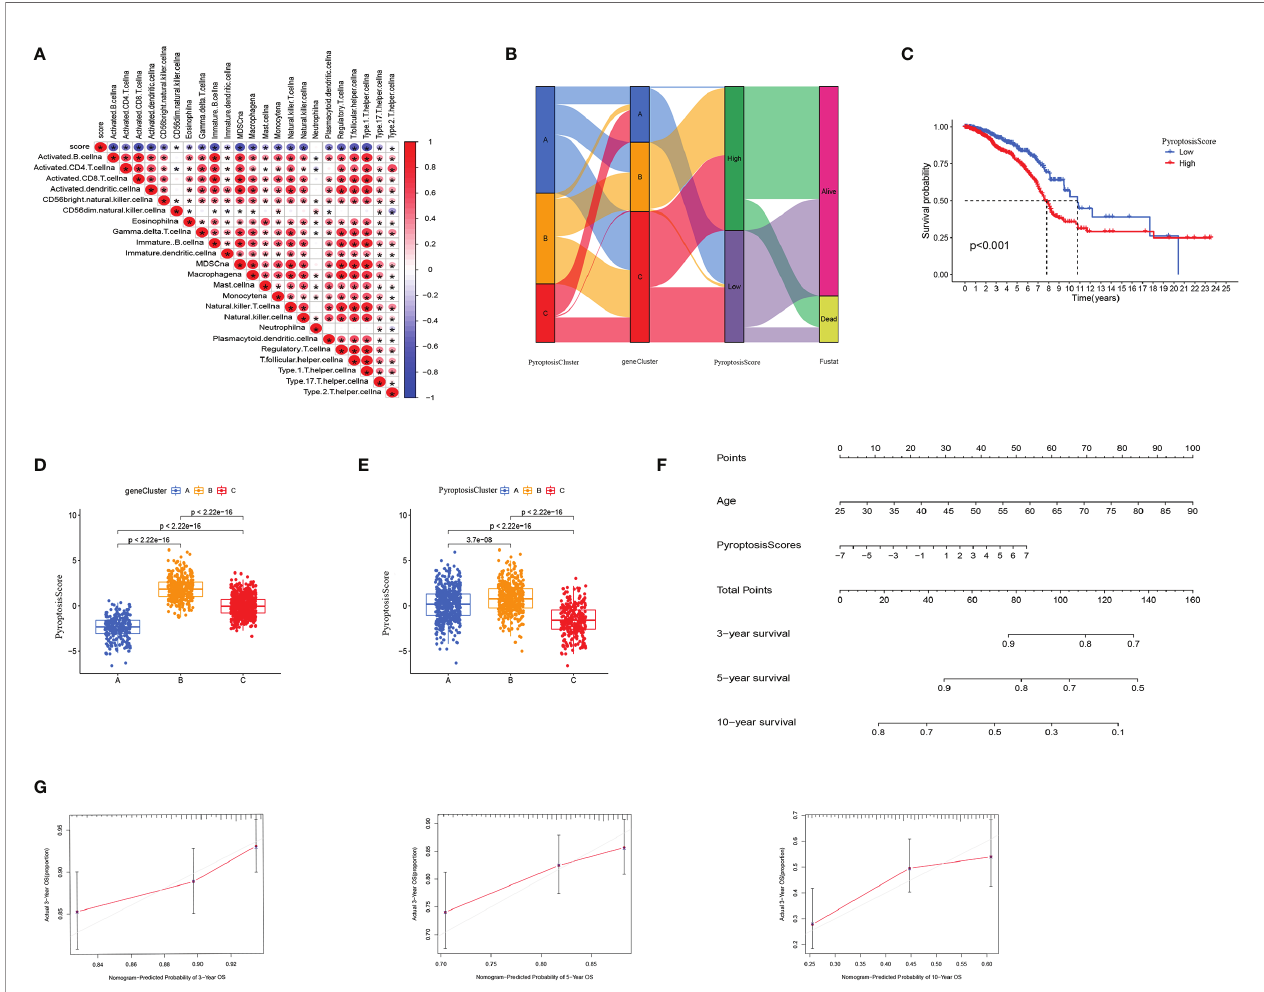
FIGURE 5 | Generation of PyroptosisScore. (A) Correlation between PyroptosisScore and immune cell in fi ltration. (B) Alluvial diagram showing the connection between pyroptosis cluster, gene cluster, and pyroptosis score. (C) The overall survival of PyroptosisScore. (D) The level of PyroptosisScore in different genecluster sub-groups. (E) The level of PyroptosisScore in different PyroptosiscCluster subgroups. (F) Nomogram to predict 3-, 5- and 10-year OS in the TCGA cohort. (G) Calibration plots of the nomogram to predict OS at 3-, 5- and 10-year. * P < 0.05, ** P < 0.01, *** P <